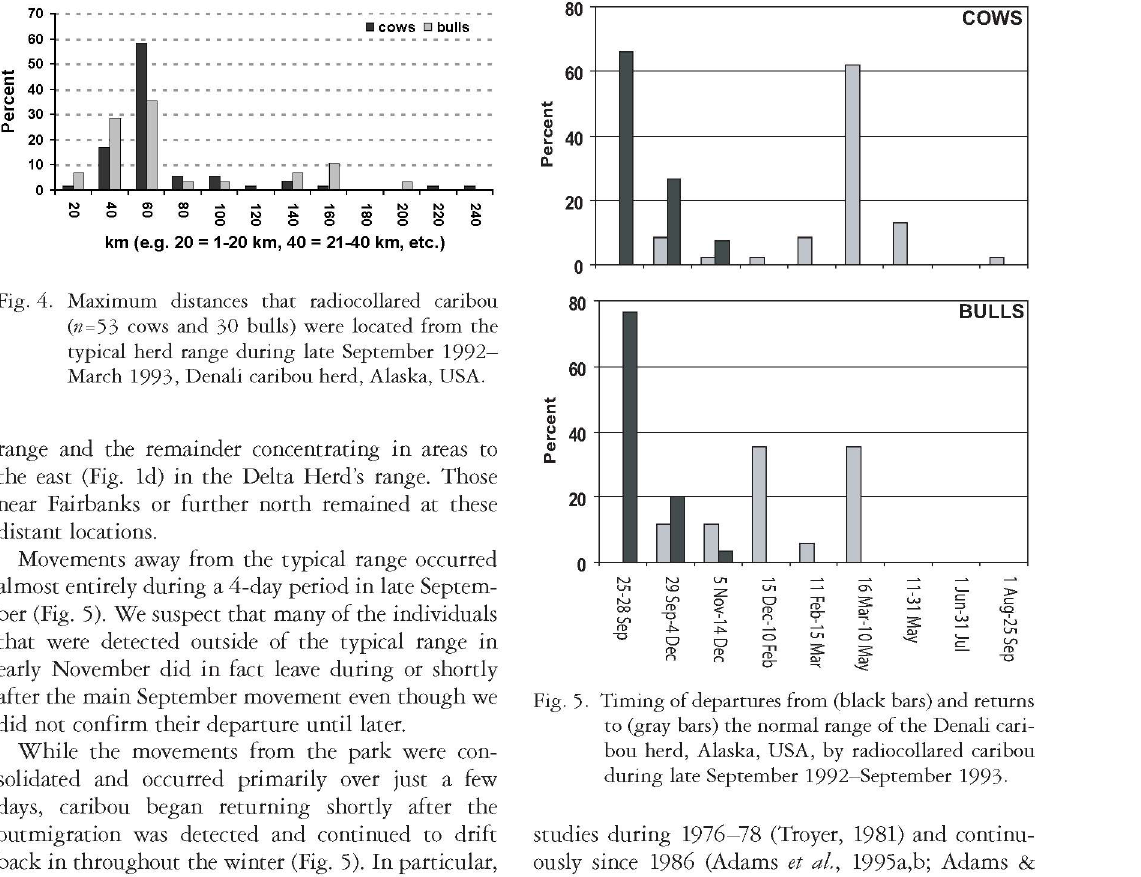
range and the remainder concentrating in areas to the east (Fig. 1d) in the Delta Herd's range. Those near Fairbanks or further north remained at these distant locations.